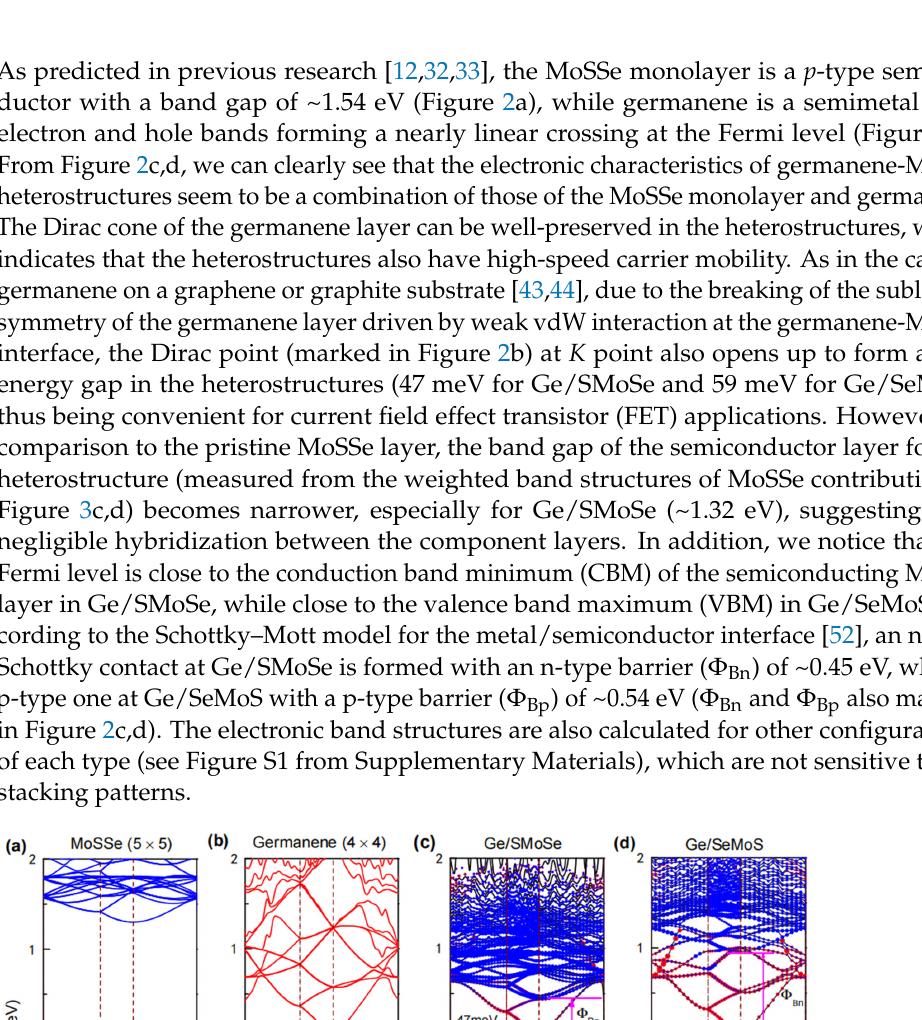
Figure 3. Electrostatic potential of ( a ) Ge/SMoSe and ( b ) Ge/SeMoS. The corresponding planar ‐ av ‐ eraged differential charge density  are shown in ( c , d ) with locations of component layers